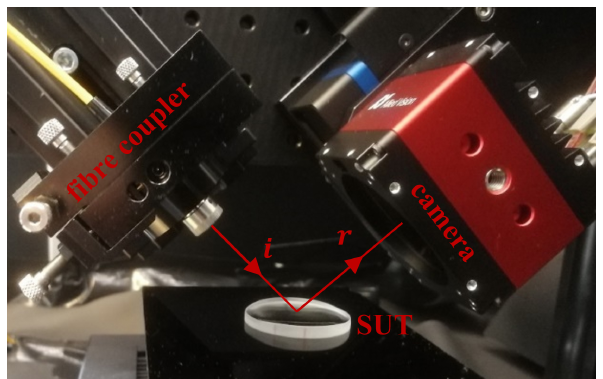
Figure 9. Image of the experimental setup with the fiber coupler including the collimator, the incident beam direction i , the SUT, the reflected beam direction r and the camera with the bare chip.